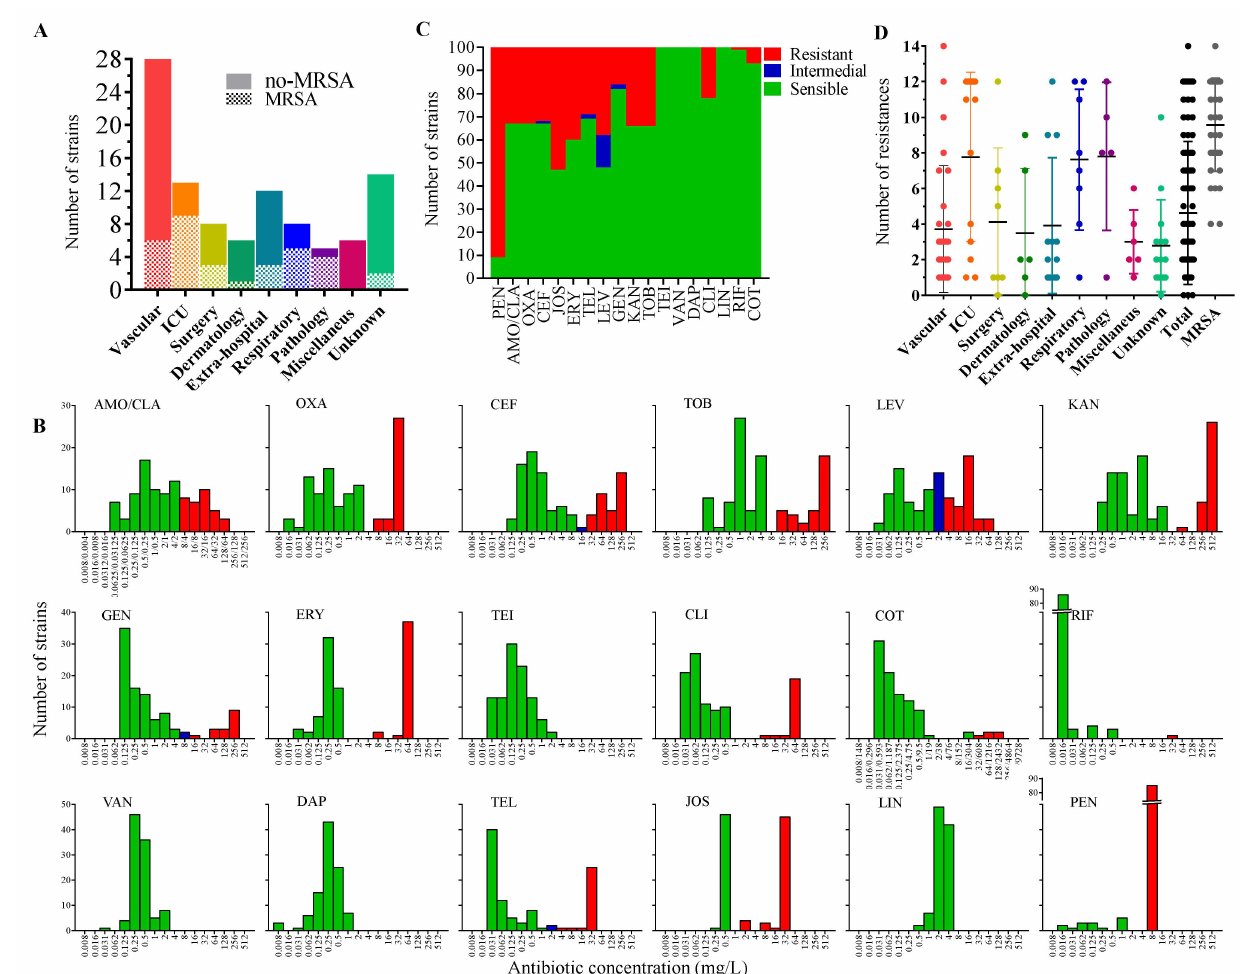
Figure 1. Antibiotic-resistance profile of the S. aureus strains. ( A ) Percentage of the S. aureus isolated in different hospital units. ( B ) S. aureus strains MIC distribution for the 18 antibiotics tested. The MICs range for sensitive strains is in green, intermedial in blue, and resistant strains in red. ( C ) The proportion of resistant, sensitive, and/or intermedial strains for each antibiotic tested. ( D ) Number of resistance identity by strain and medical care unit. Each dot represents one strain. MRSA indicates the number of resistances in OXA resistant strains. Miscellaneous represents a group of samples isolated from different hospital-care units such as Oncology (2), Rheumatology (1), Infectious Diseases (1), Pediatric (1), and Otorhinolaryngology